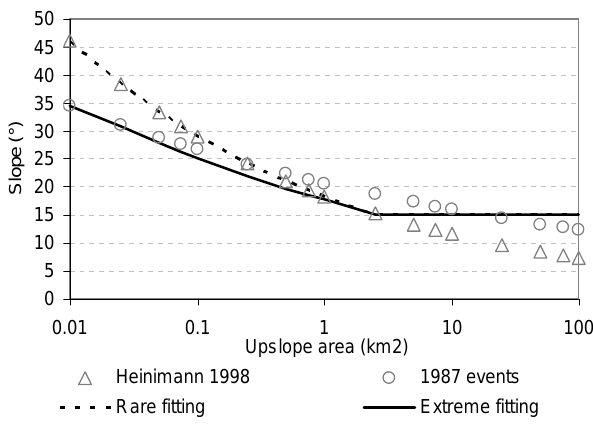
Fig. 3. Curves showing the initiation threshold of debris flows considering the slope angle and the upslope contributing area (flow accumulation). In the analysis the extreme fitting curve was used (after Horton et al.,